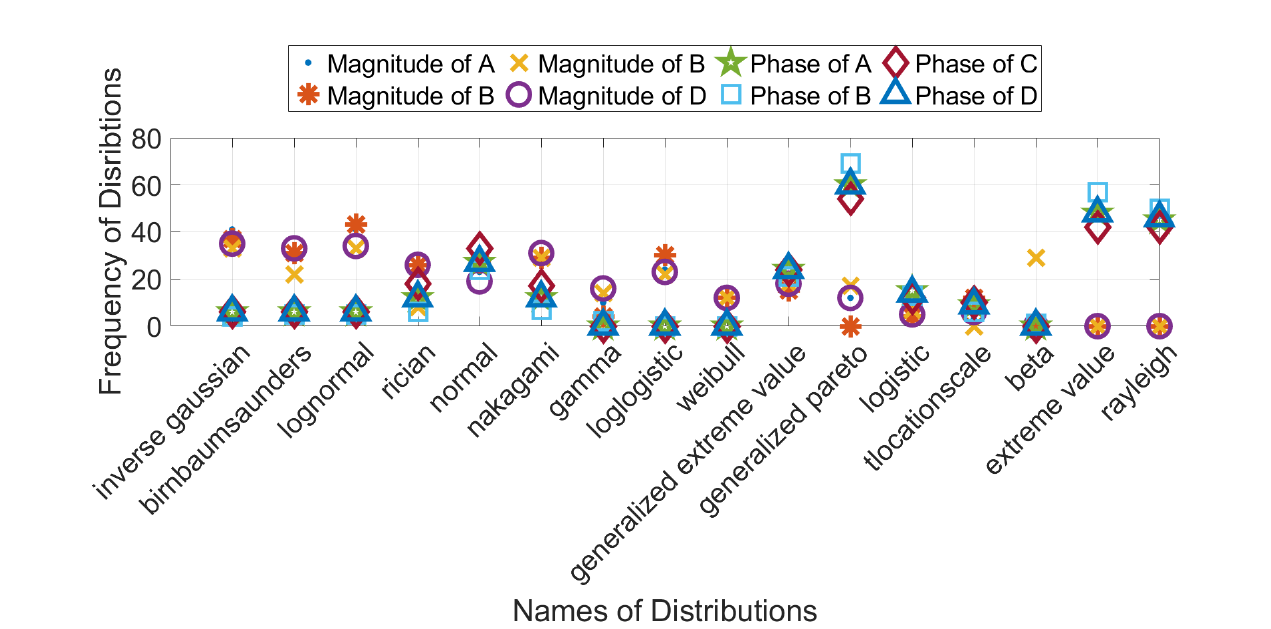
Figure 5: Frequency of Distribution Names (Considering the Top 3 Best Fit Distributions) for the Cascaded ABCD Random Variable Matrix Elements Considering both Magnitude and